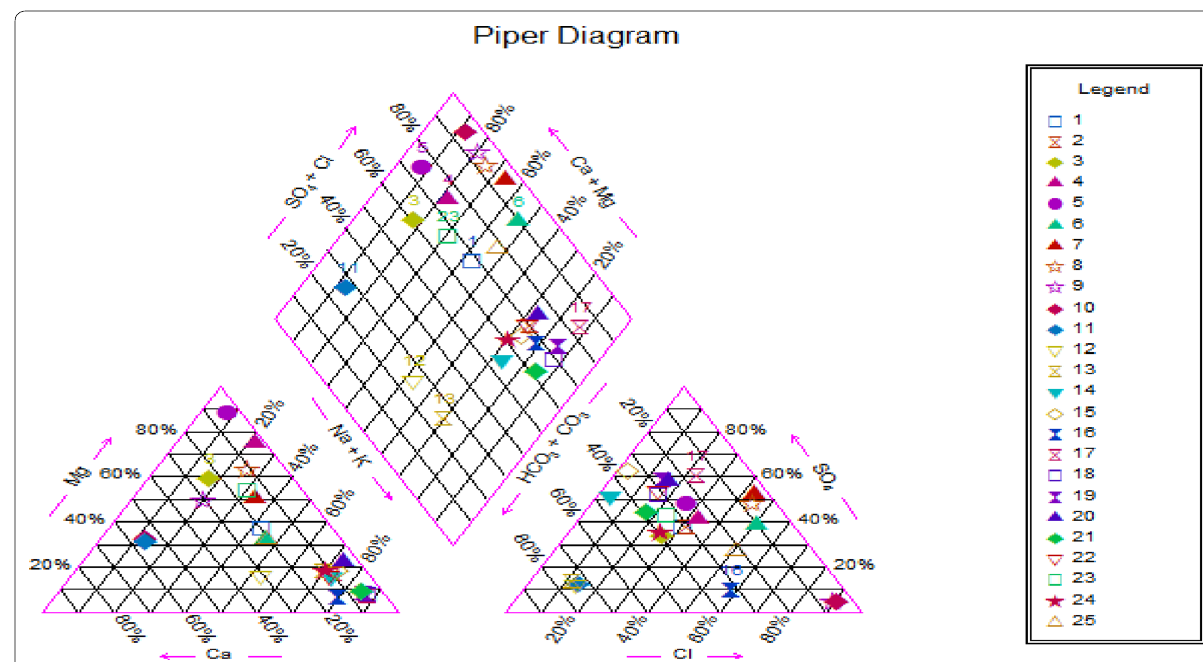
Fig. 6 Piper diagram displaying the hydrological facies of the borehole